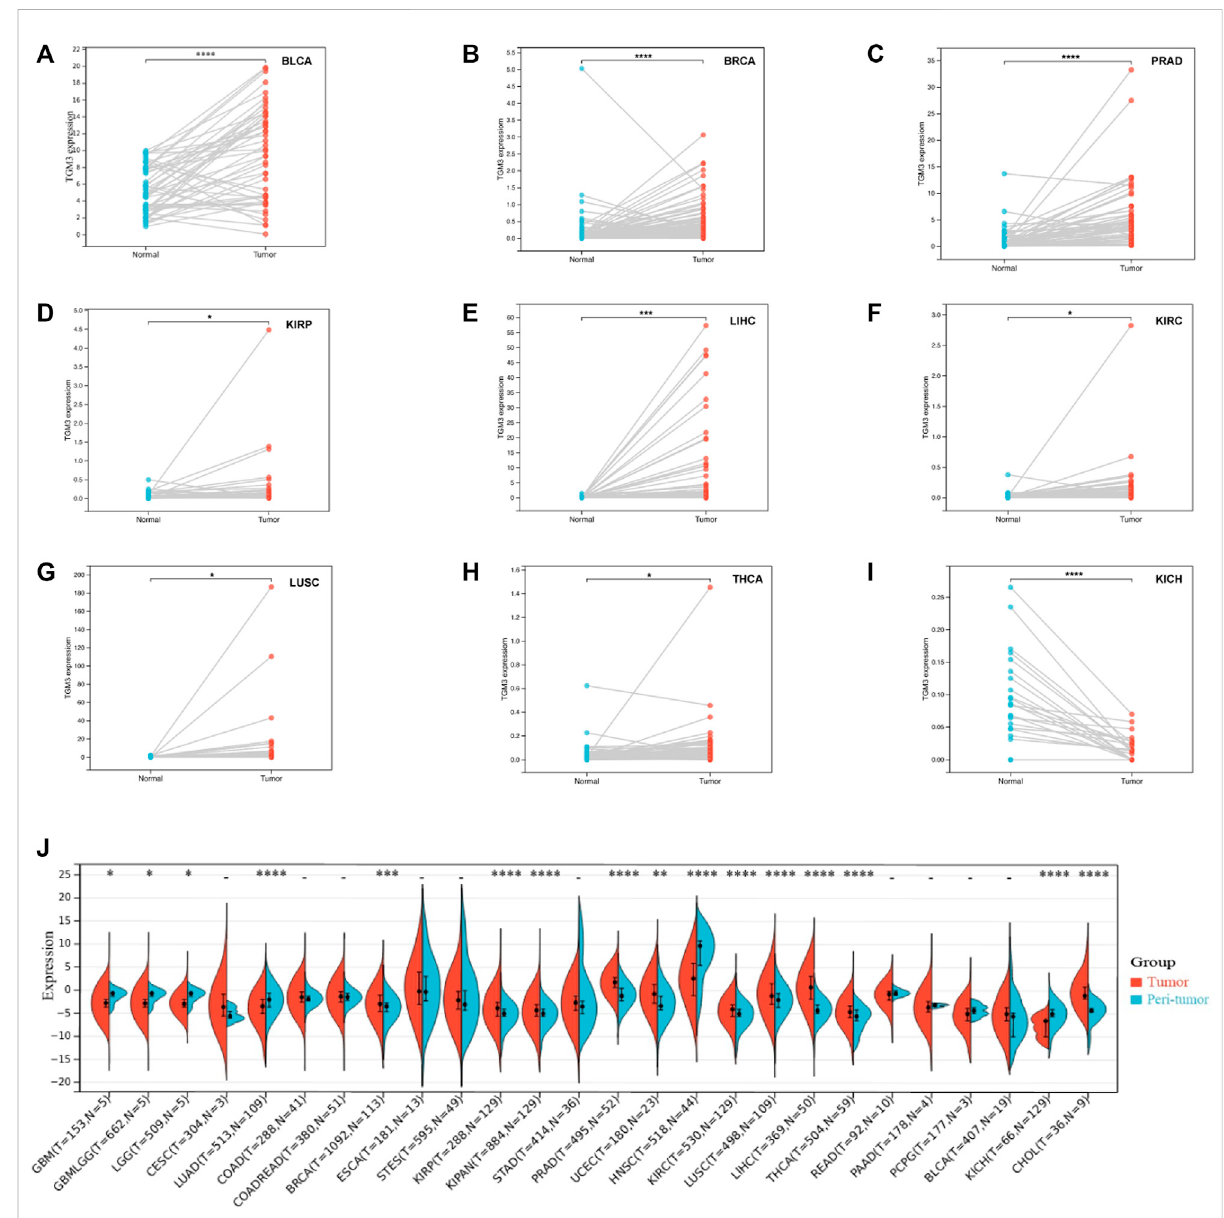
FIGURE 4 PairedTGM3expressionlevelinpan-cancer. (A – I)